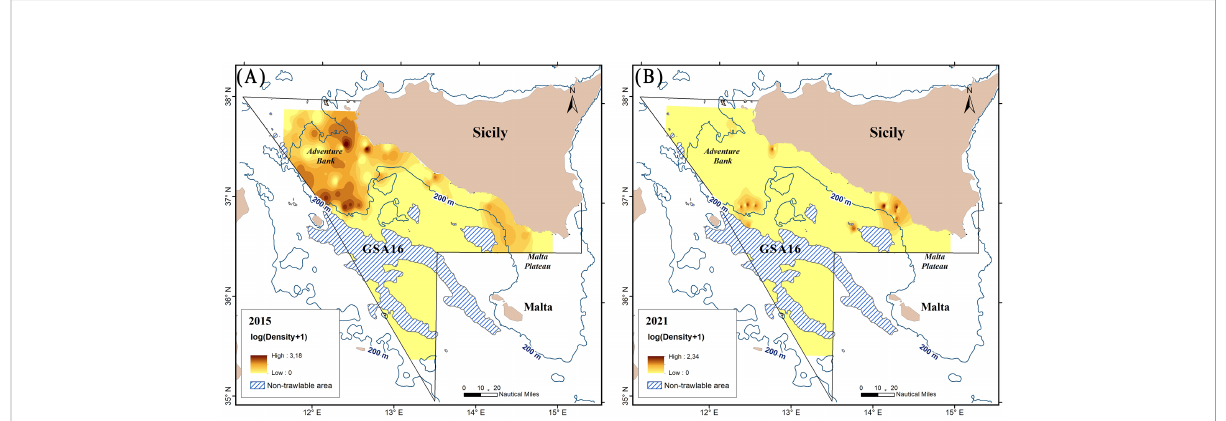
FIGURE 4 Spatial distribution, in terms of the logarithm of density index [(N+1)/km2], of P. regalis in the study area (GSA 16) (A) of the year (2015) with the highest density index in the steady-state phase (2008 – 2017) and (B) the last year (2021) of the declining phase (2018 – 2021) according to the temporal trend of the abundance of the species. The dashed areas depict water depths of more than 800 m not investigated during the MEDITS